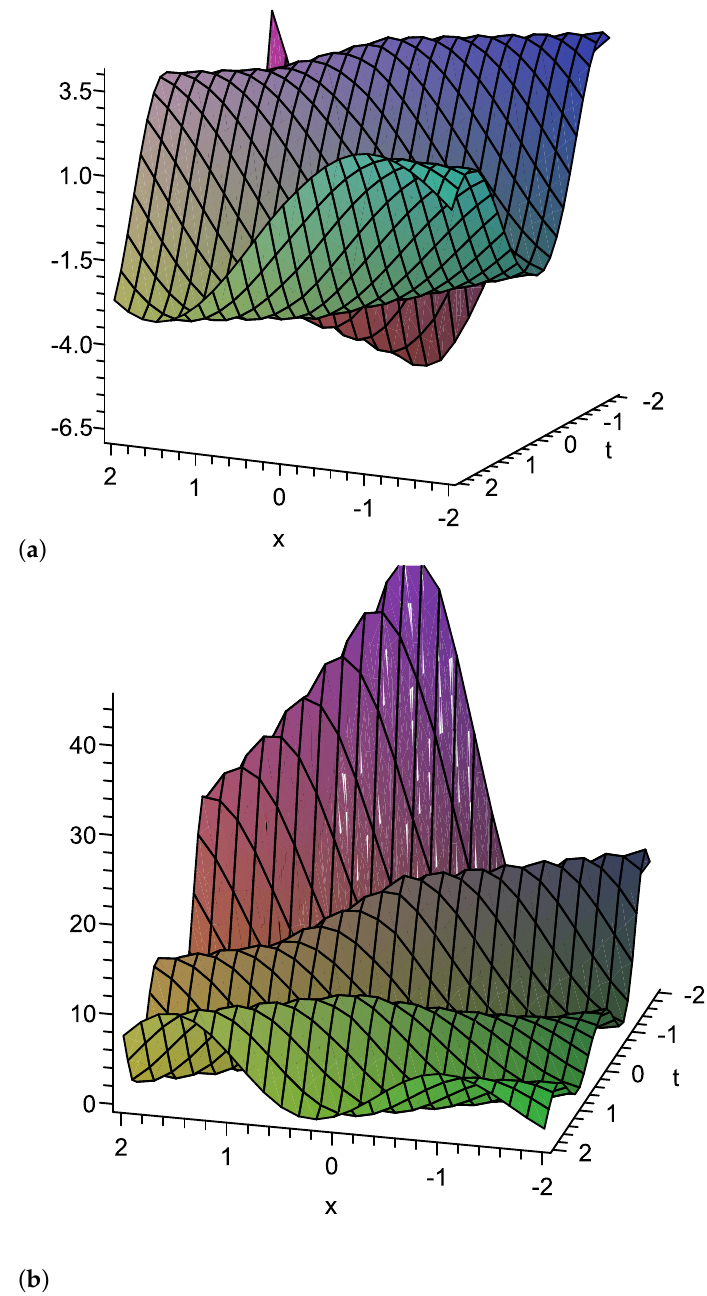
Figure 5. The first and second moments for the random solution sq 9 in (53); α is a beta random variable and − 2 ≤ t , x ≤